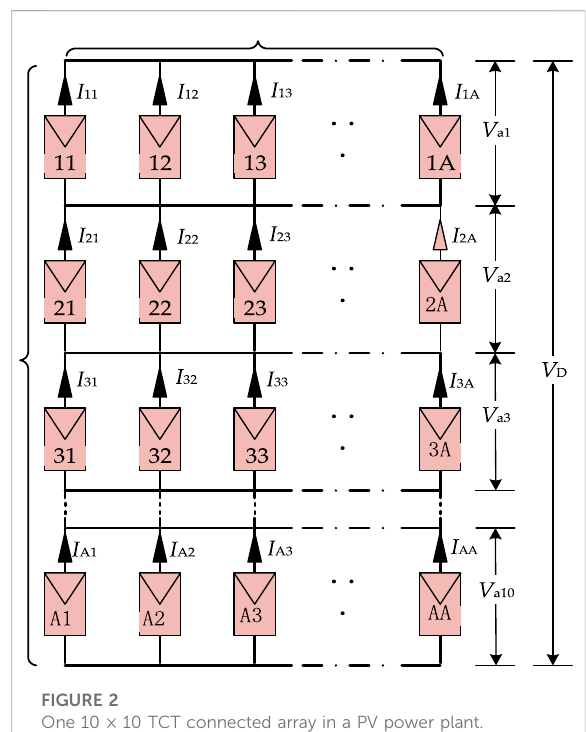
FIGURE 2 One 10 × 10 TCT connected array in a PV power